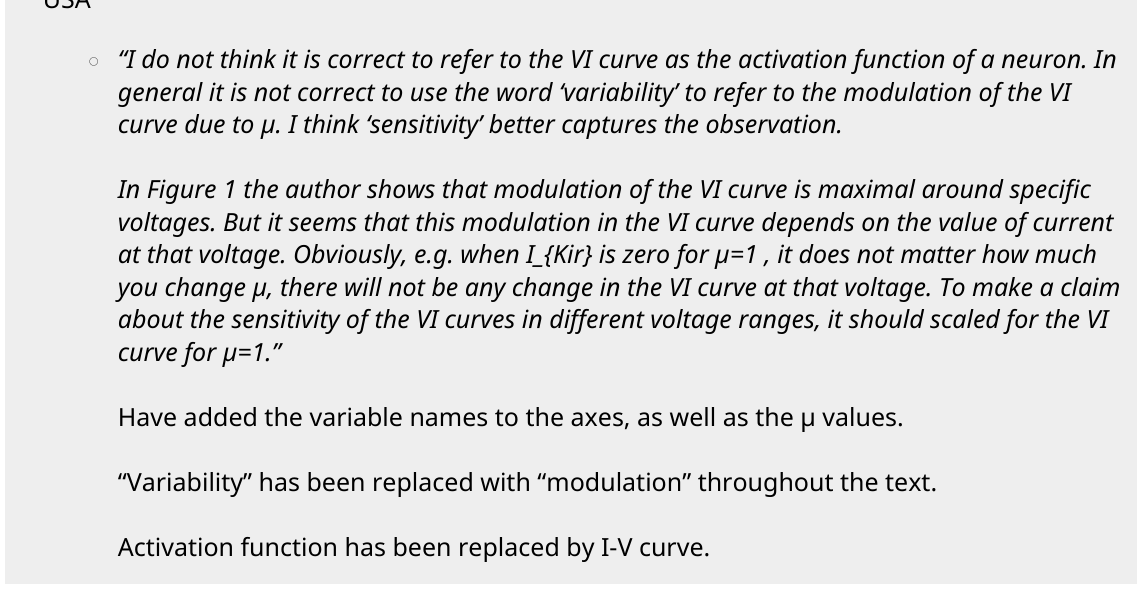
Figure 2: Once again I am not sure which axis shows the variability? And axis on the insets are missing. Figure 3: Render the different lines in colours which reflect the voltage. In its current form it's not easy to read these figures. Figure 4: the o/p is shown for only one value of i/p firing rate (couldn't find any mention of what value it is). Hence, in addition to the present figure 4, a figure showing i/p firing rate Vs o/p firing rate for more than one data point of i/p firing rate could be included. This can be plotted for all the three values of μ. This on the other hand could be drawn for few values of i/p correlations. Figure 8: It is not clear if the traces are drawn for +ve or -ve learning. The labels of neuron numbers (No. 4,8) are right if it's for negative learning, but should be in reverse order if it's for positive